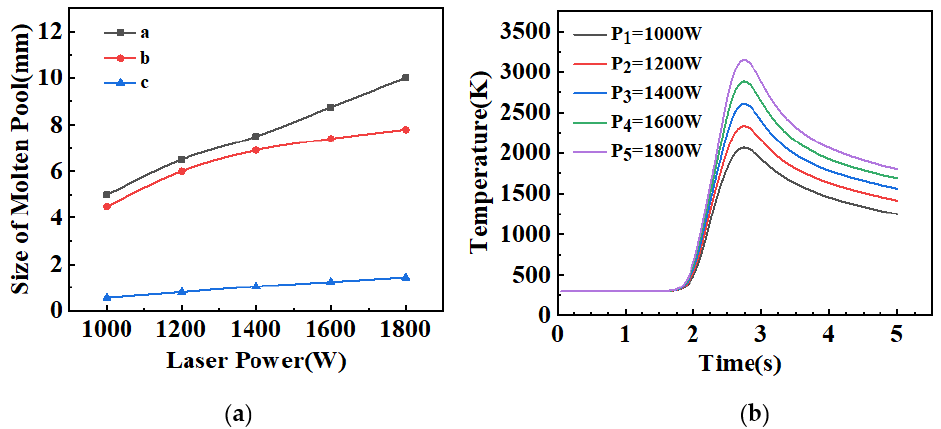
Figure 4. ( a ) Influence of laser power on molten pool morphology; ( b ) influence of laser power on peak temperature